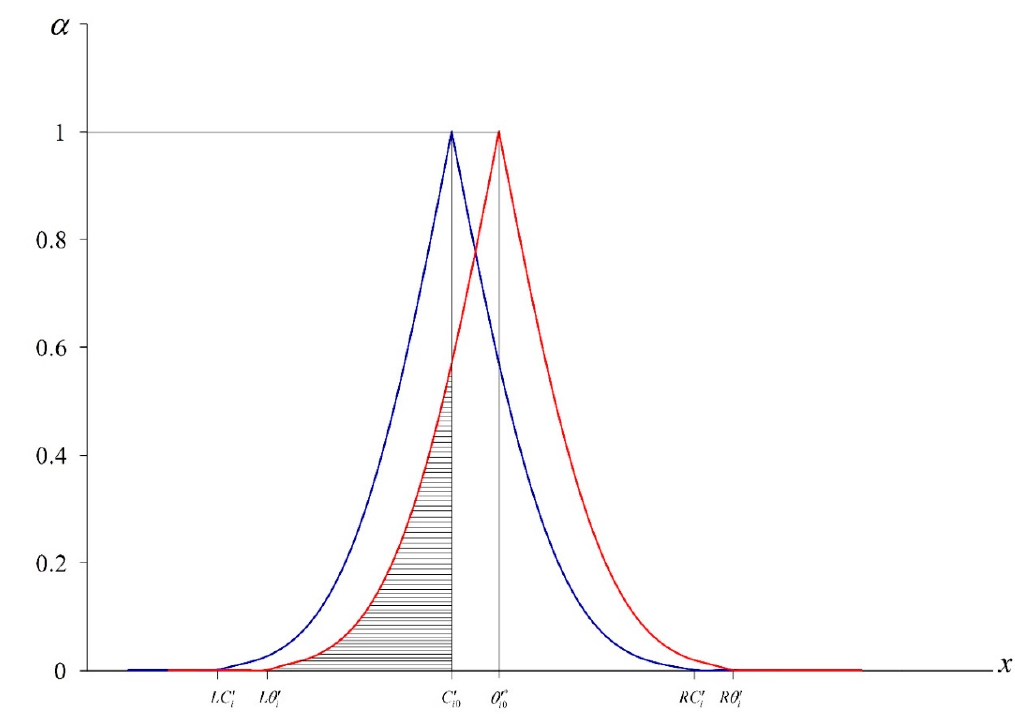
( x ) and η (cid:48) ( x ) o i x η′ and ( ) x η′ . i o